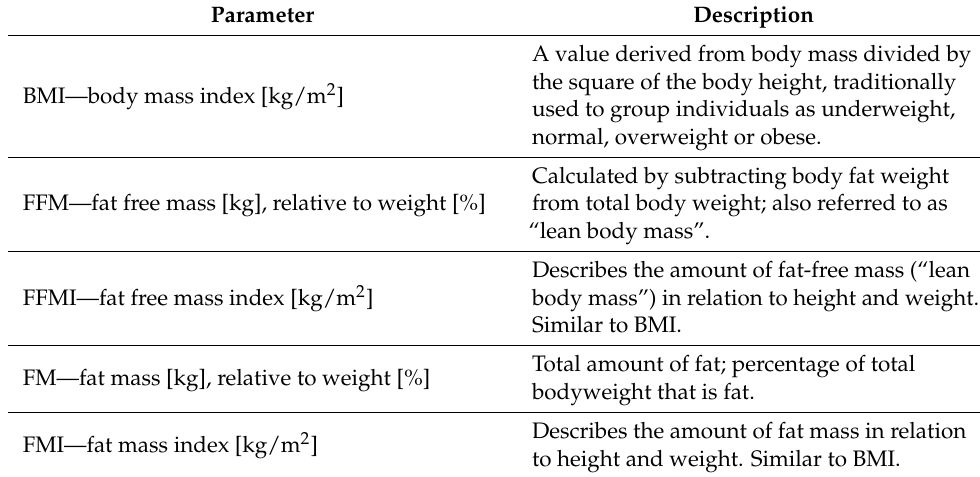
Table 1. List of measured body composition